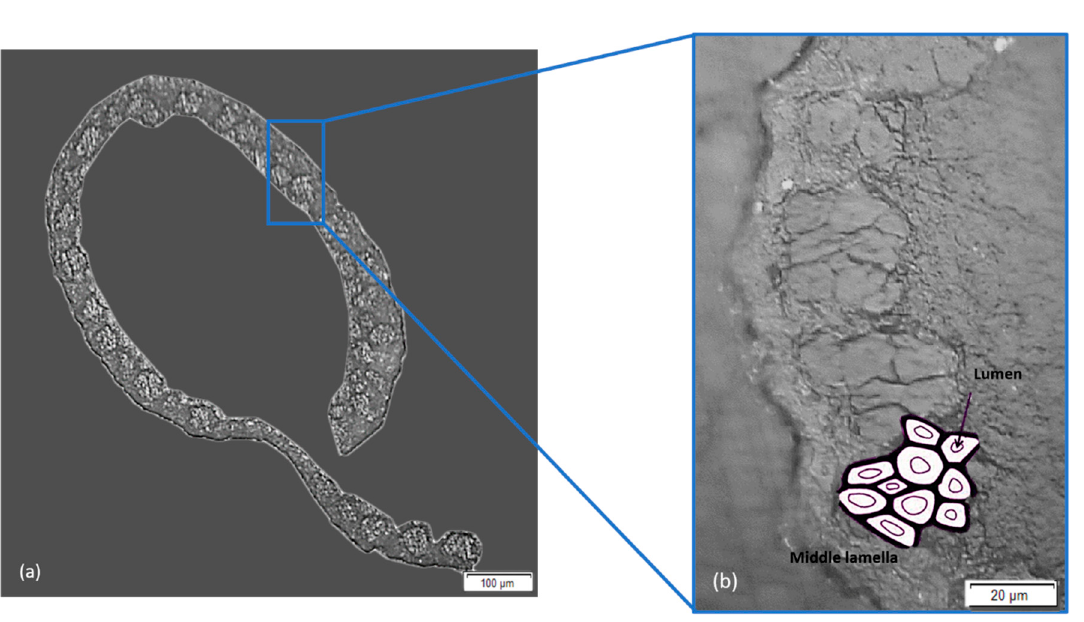
Figure 4. Cross-section morphology of the tucum fiber bundle ( a ) 10× and ( b )50×.